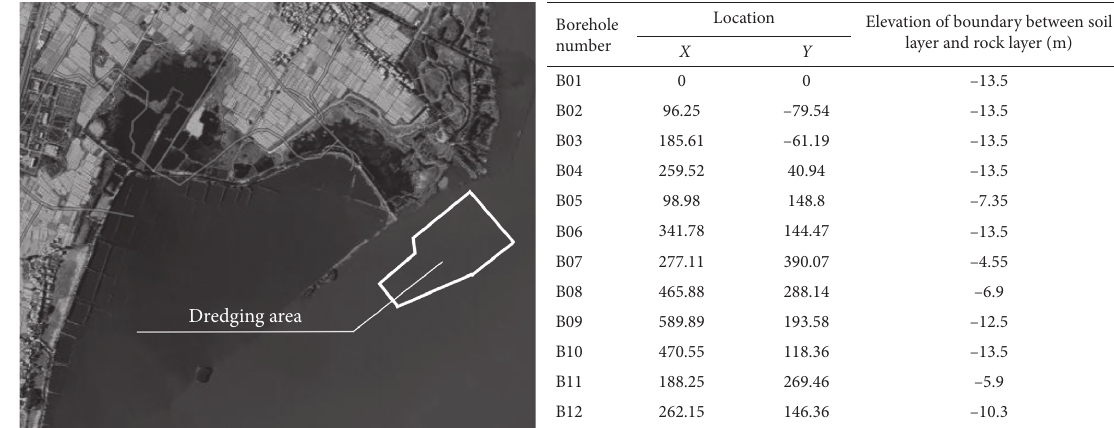
Figure 3: Project area and borehole information.